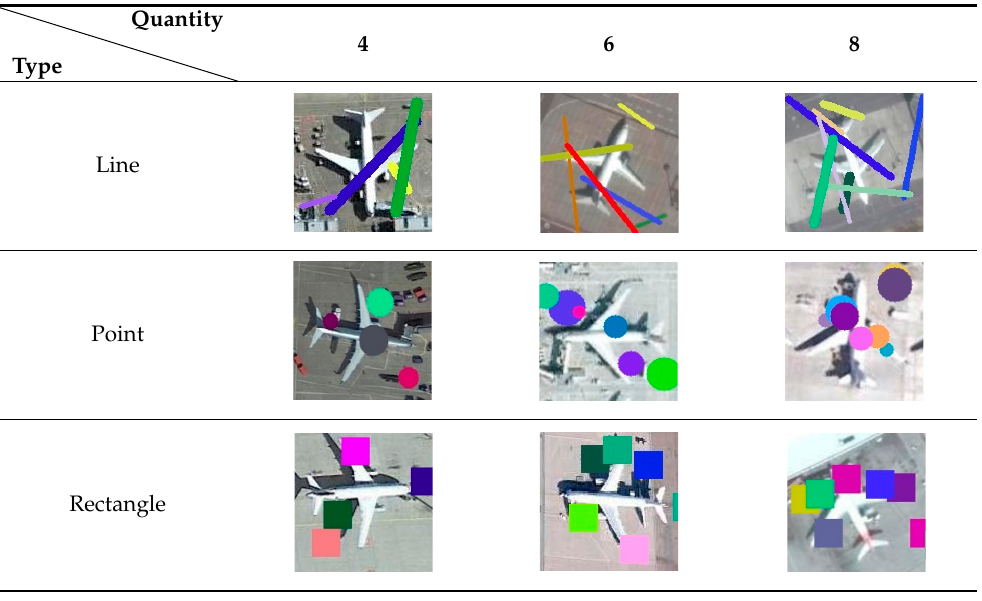
Table 4. Style transfer result on Table 3.